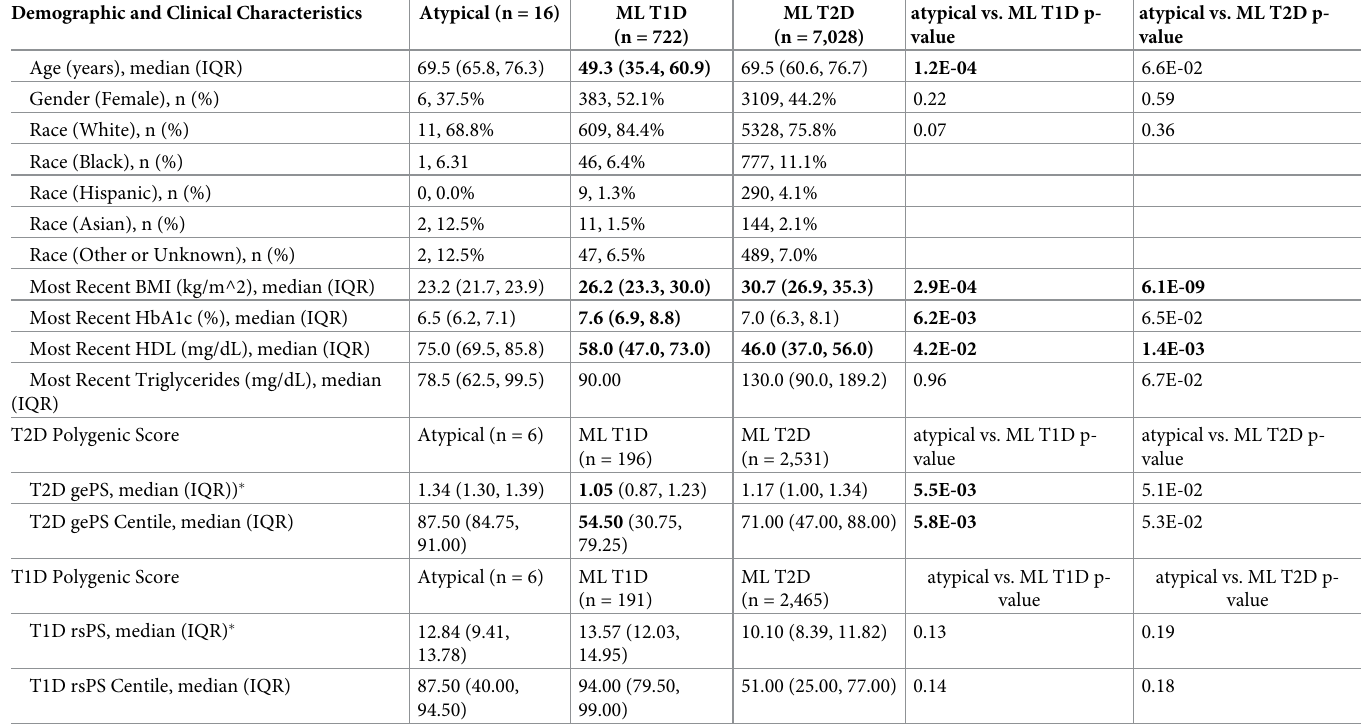
� For the ML T1D and T2D groups, this includes scores only from individuals of European ancestry with genetic information. As the polygenic scores were developed in European populations, they are more reliable in this population, and values in non-European individuals and scores calculated in non-European populations are systematically skewed. All individuals with AD and genetic information available were of European